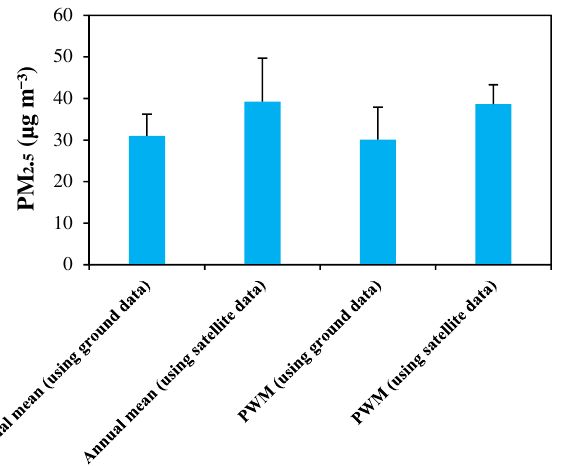
Figure 2. Annual mean and population-weighted mean (PWM) concentrations for ambient PM 2.5 in Iran, 2018, based on ground and satellite